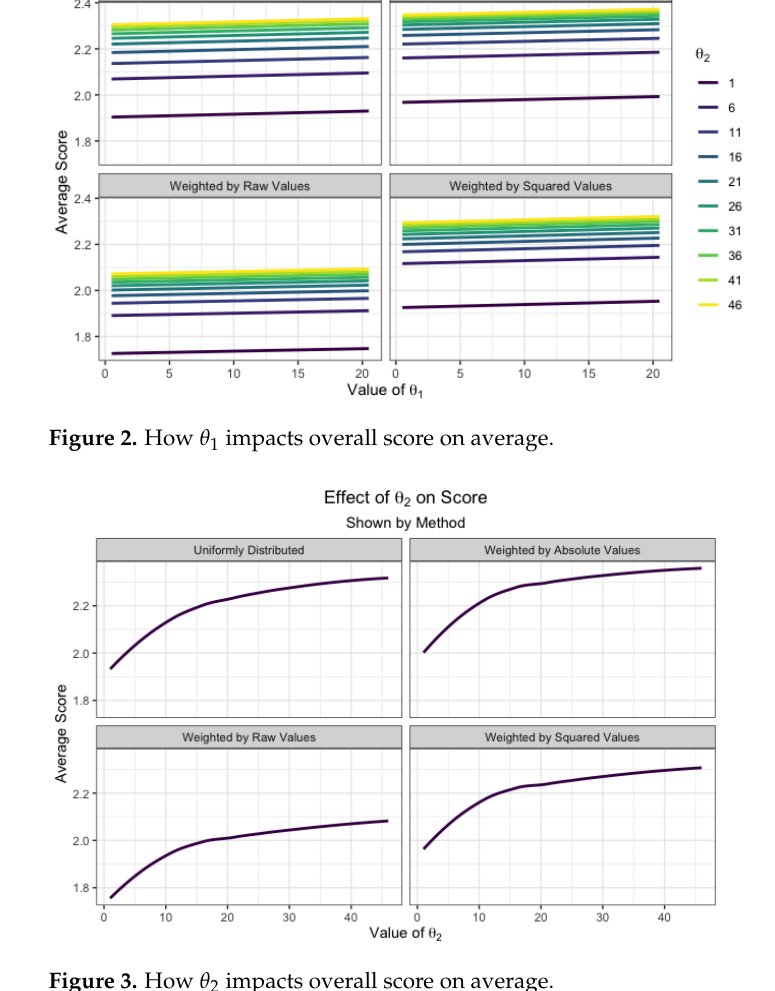
Figure 3. How θ 2 impacts overall score on